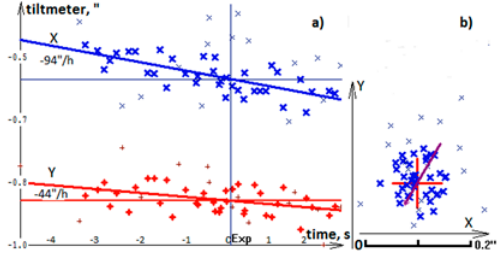
Fig. 4. Tiltmeter readings during frame exposure: a) dependence on time; b) in tiltmeter coordinate system. Approximating linear trend outlined. Outlying (thin) points were removed from